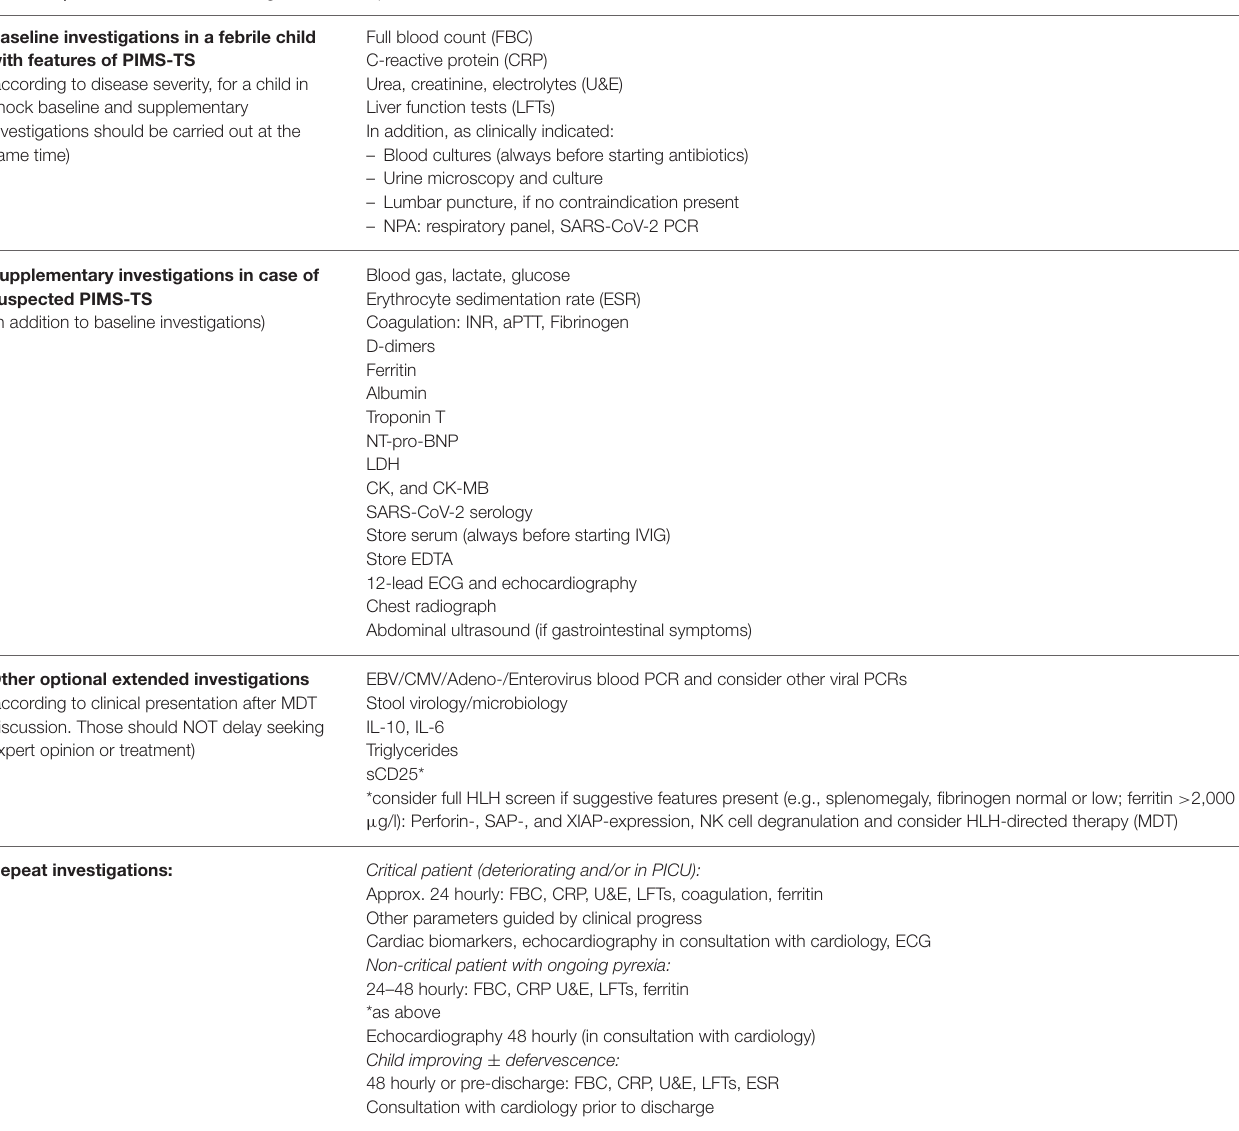
TABLE 2 | Recommendations for diagnostic work-up in children evaluated for PIMS-TS. Baseline investigations in a febrile child with features of PIMS-TS (according to disease severity, for a child in shock baseline and supplementary investigations should be carried out at the same